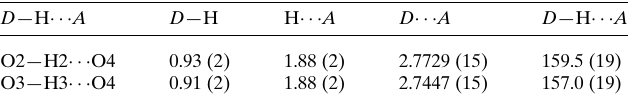
Table 1 Hydrogen-bond geometry (A˚ , (cid:3) ).